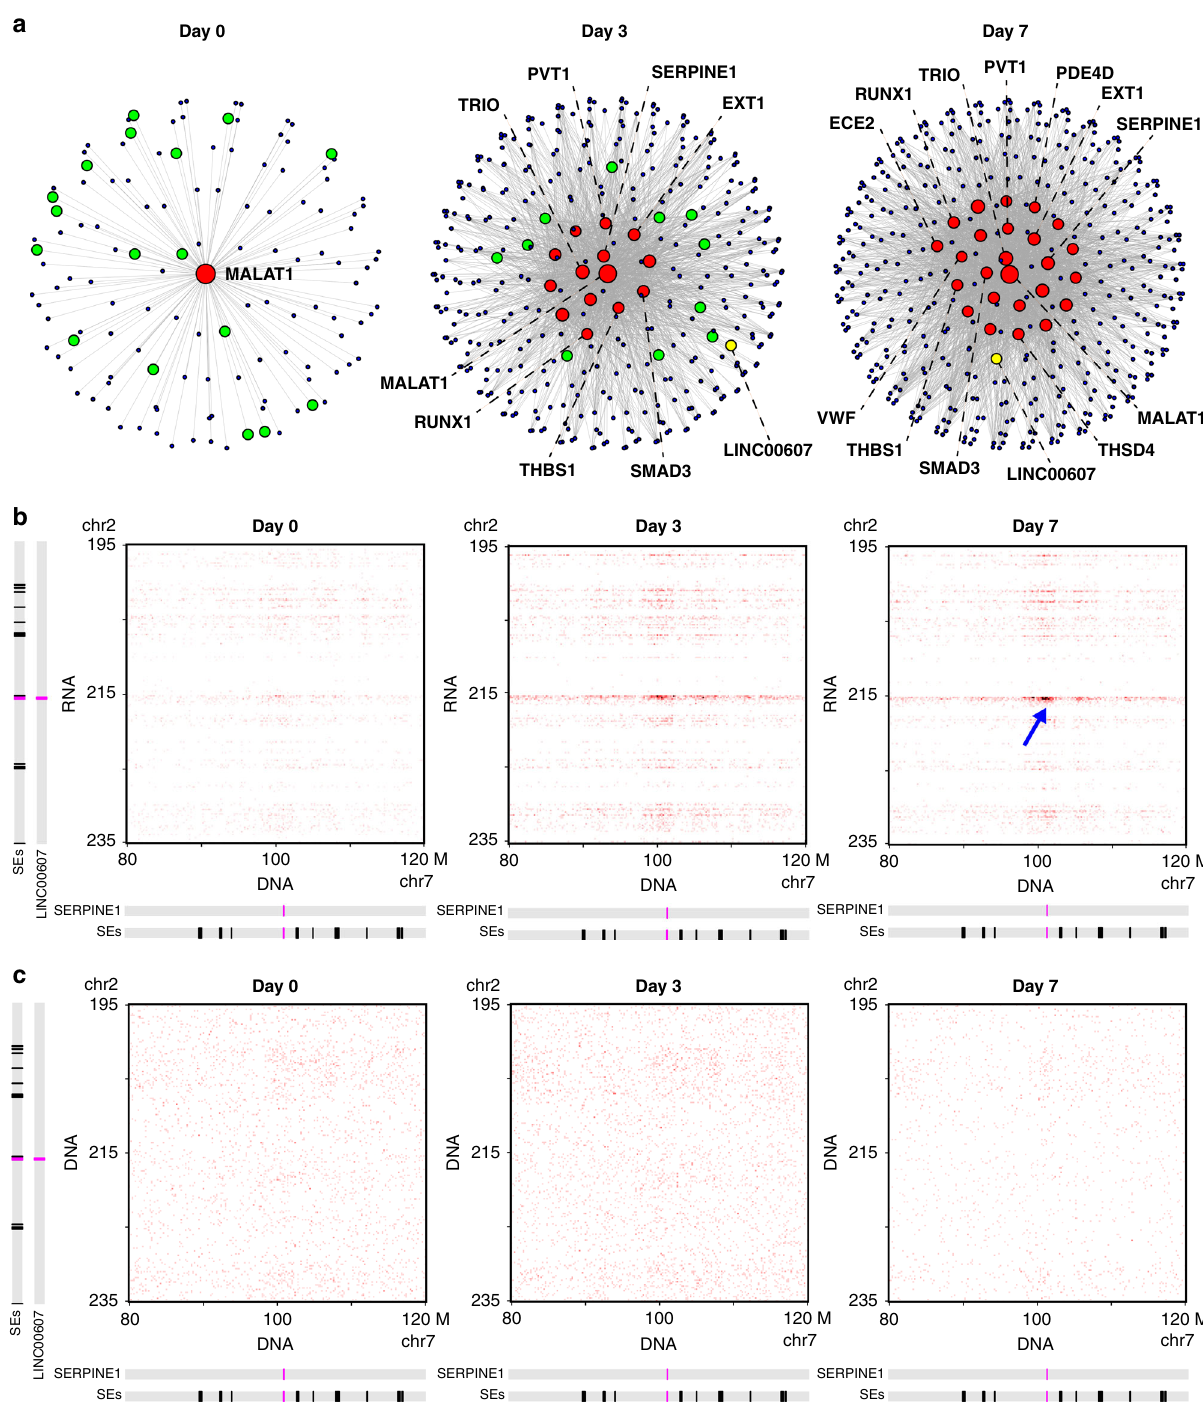
Fig. 3 Hub SEs induced by H + T contain driver genes of EC dysfunction. a Interchromosomal RNA – chromatin interaction networks. Each node is a SE. Each edge is an interchromosomal interaction between two SEs. Red nodes: hub SEs. Green nodes: SEs that became hub SEs at the next time point. Yellow node: Linc607SE . The SEs that contain EC dysfunction-related genes are marked with the gene name. b , c Contact matrices between chromosome 2 (195 – 235 Mb) and chromosome 7 (80 – 120 Mb). b iMARGI derived contact matrices from the RNA (rows) to DNA (columns) in Days 0 (left), 3 (middle), and 7 (right) ECs. Blue arrow: interactions between Linc607SE and Serpine1SE established at Day 7. c Hi-C derived contact matrices. Locations of SEs, LINC00607 , and SERPINE1 are marked on the left and at the bottom. Resolution = 200